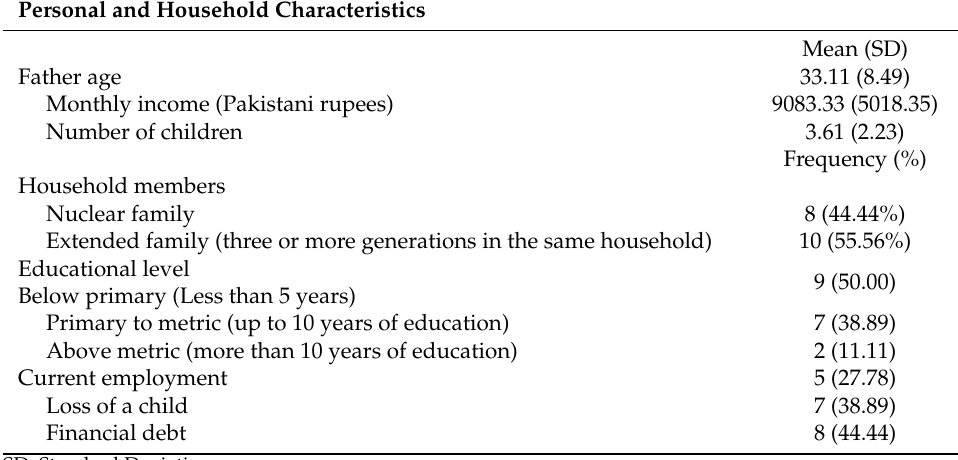
Table 1. Participant characteristics.